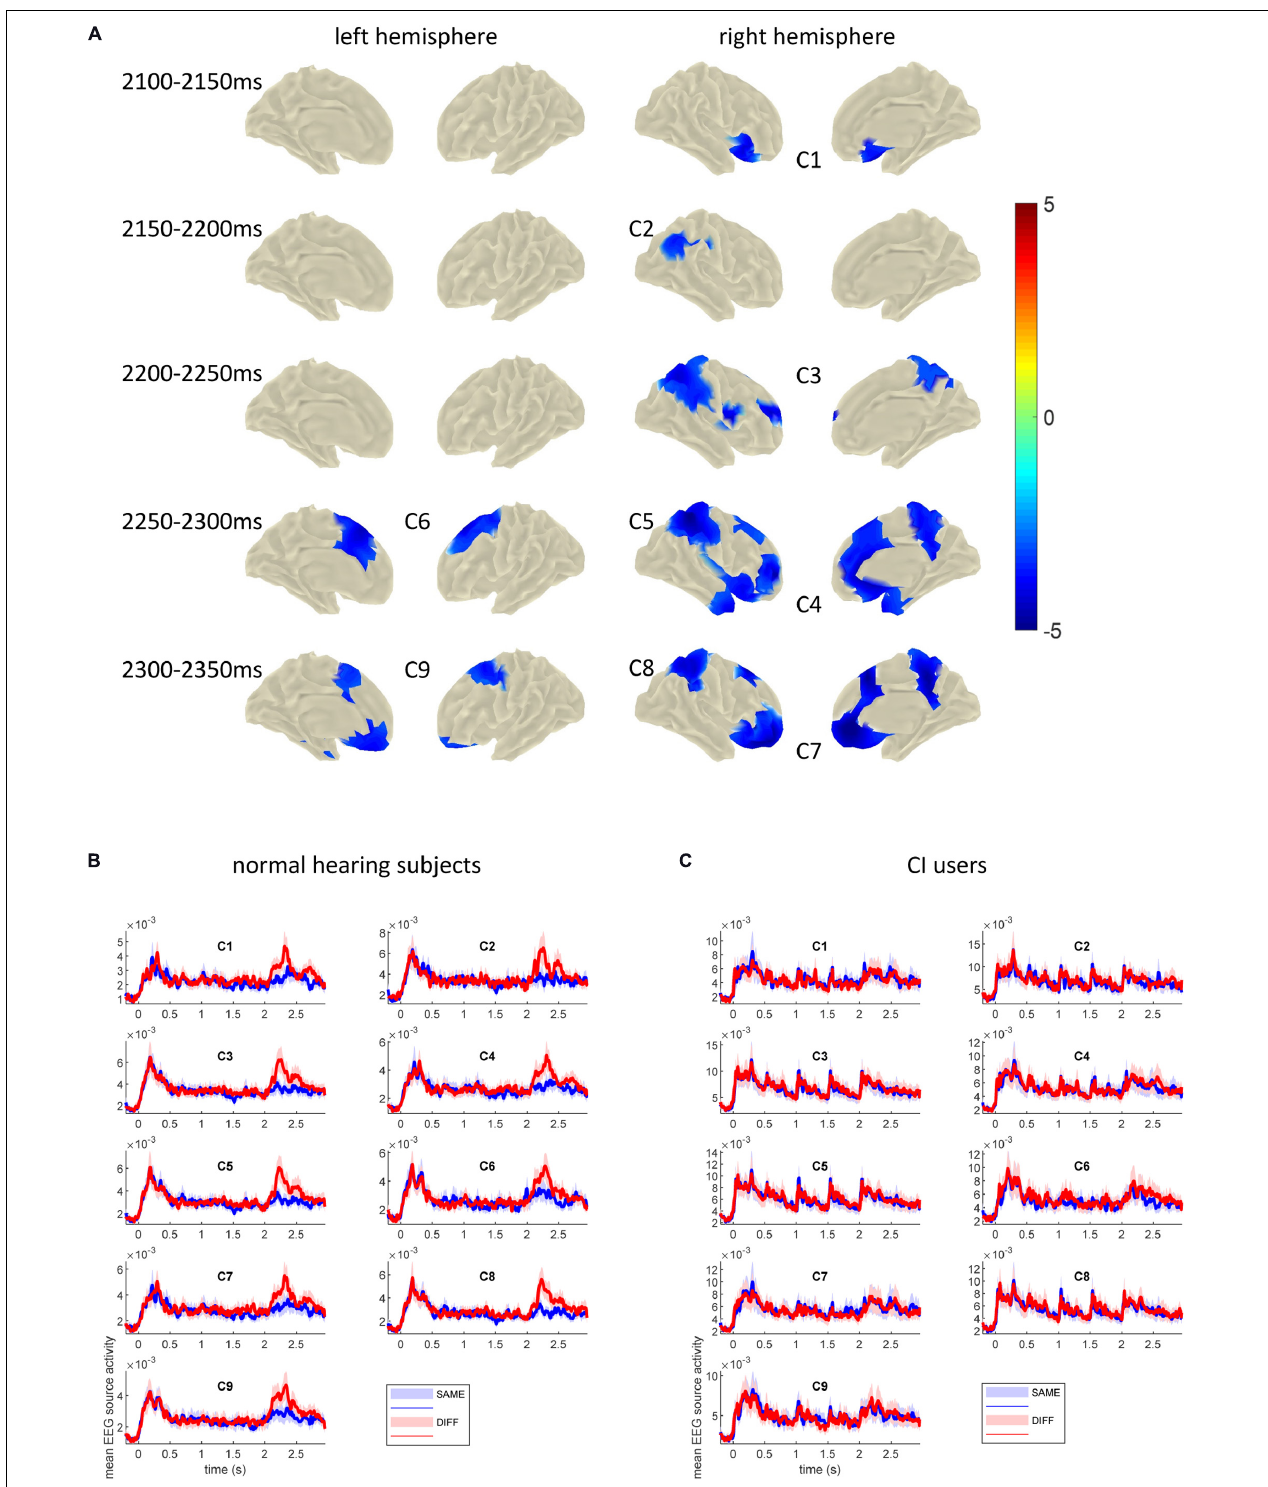
FIGURE 5 | (A) Clusters showing significantly stronger activation in DIFF than in SAME conditions across 17 normal hearing subjects tested in the indicated time windows. The onset of the probe sound was at 2000 ms. These clusters were defined as COIs for further analysis in the CI users. Color bar depicts t -values. (B) Mean EEG source time courses (arbitrary unit, root sum square of three dipole moments of each source vertex) in each COI across 17 normal hearing subjects. (C) Mean EEG source time courses in each COI across 13 CI users. The bounded lines indicate ± SEM.